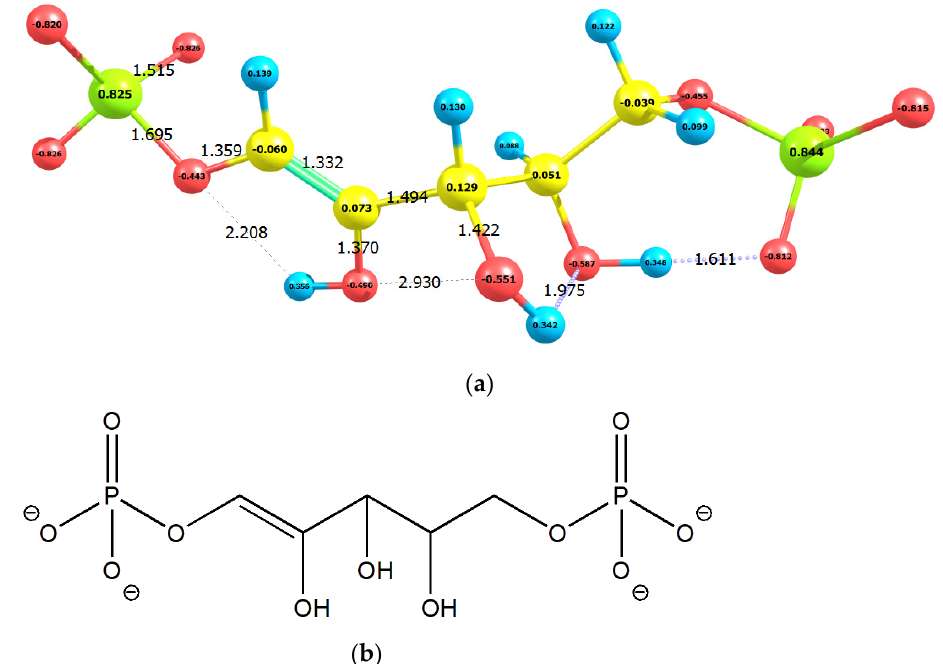
Figure A4. ( a ) The calculated geometric and electronic structure of 1/2-ene(mono/di)ol (1,2-enol); Q = -4, M = 1, E 0 = − 46,437.76 eV, G 0 = − 46,434.44 eV. Hessian has no negative frequencies. ( b ) The scheme of (Z)-2,3,4-trihydroxypent-1-ene-1,5-diyl diphosphate.